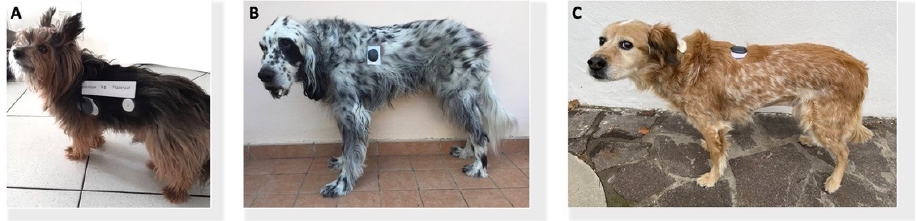
Figure 3. ( A ) Dog 1 wearing Eversense XL ( left ) and FreeStyle Libre ( right ); ( B ) Dog 2 wearing Eversense XL; ( C ) Dog 3 wearing Eversense XL ( right ) and FreeStyle Libre ( left ).